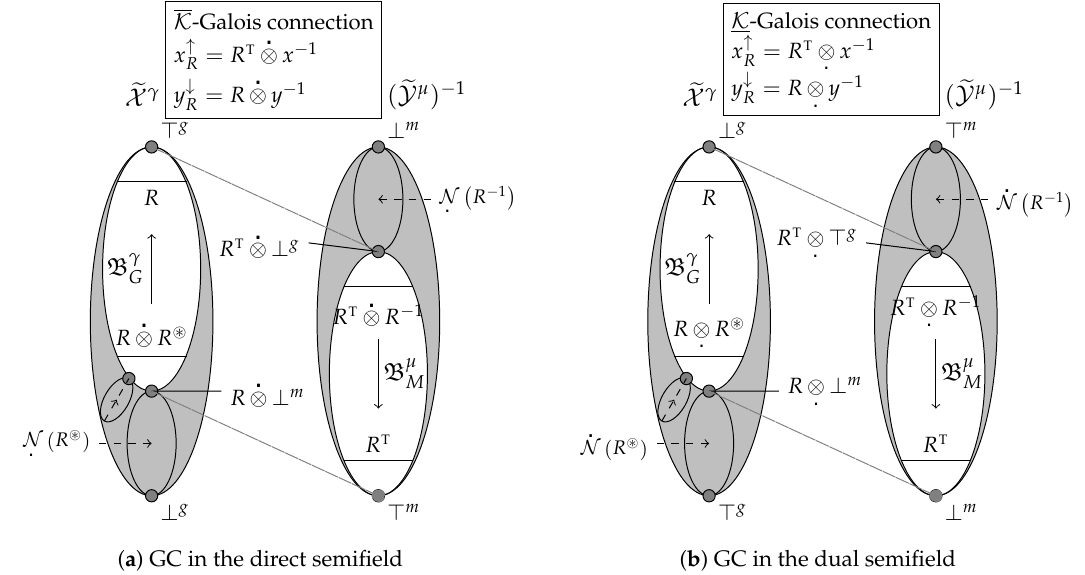
Figure 3. Schematics of the Galois connection in the formal concept lattices of ( G , M , R ) for the direct and inverse semifields (see Section 2.2.3) for an invertible ϕ . White ovals: concept lattices. Grey shaded areas: bikernels. Grey ovals: bikernel blocks. The increasing sense of the orders is schematised with arrows. The dashed slanted lines connect the extent and intent of some ϕ -concepts. (improved, enriched from